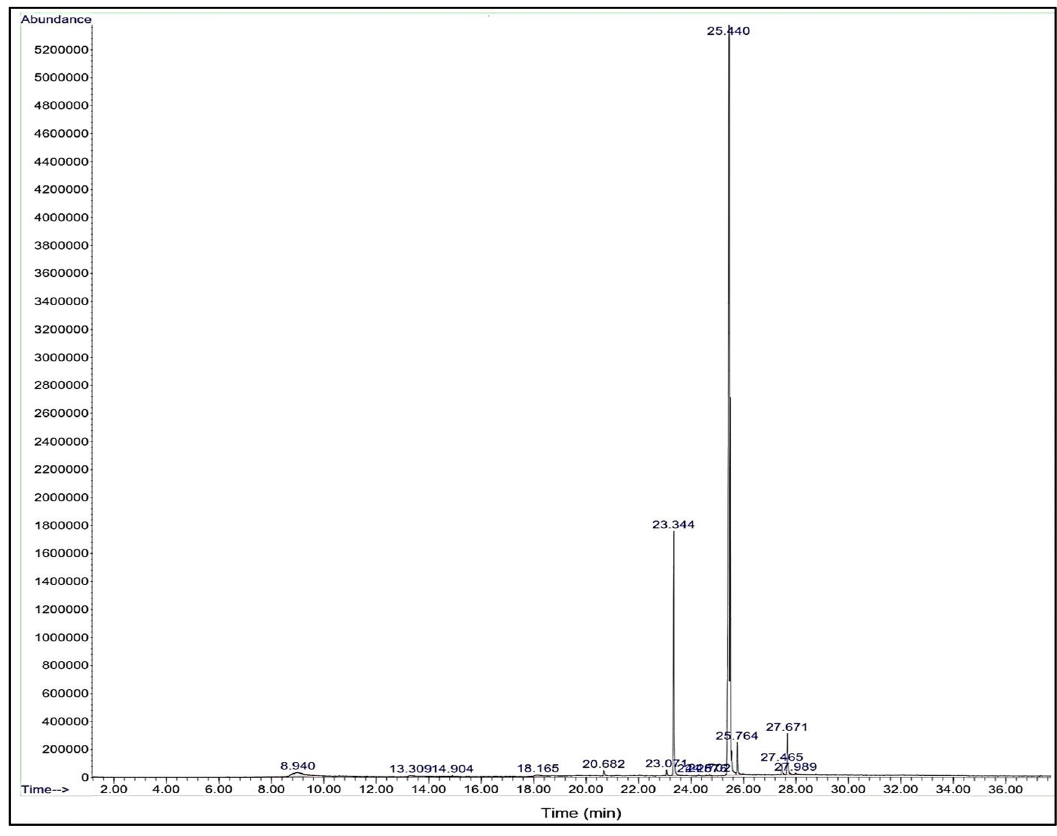
Figure 1: Chromatogram of the ethanolic extract of N. sativa